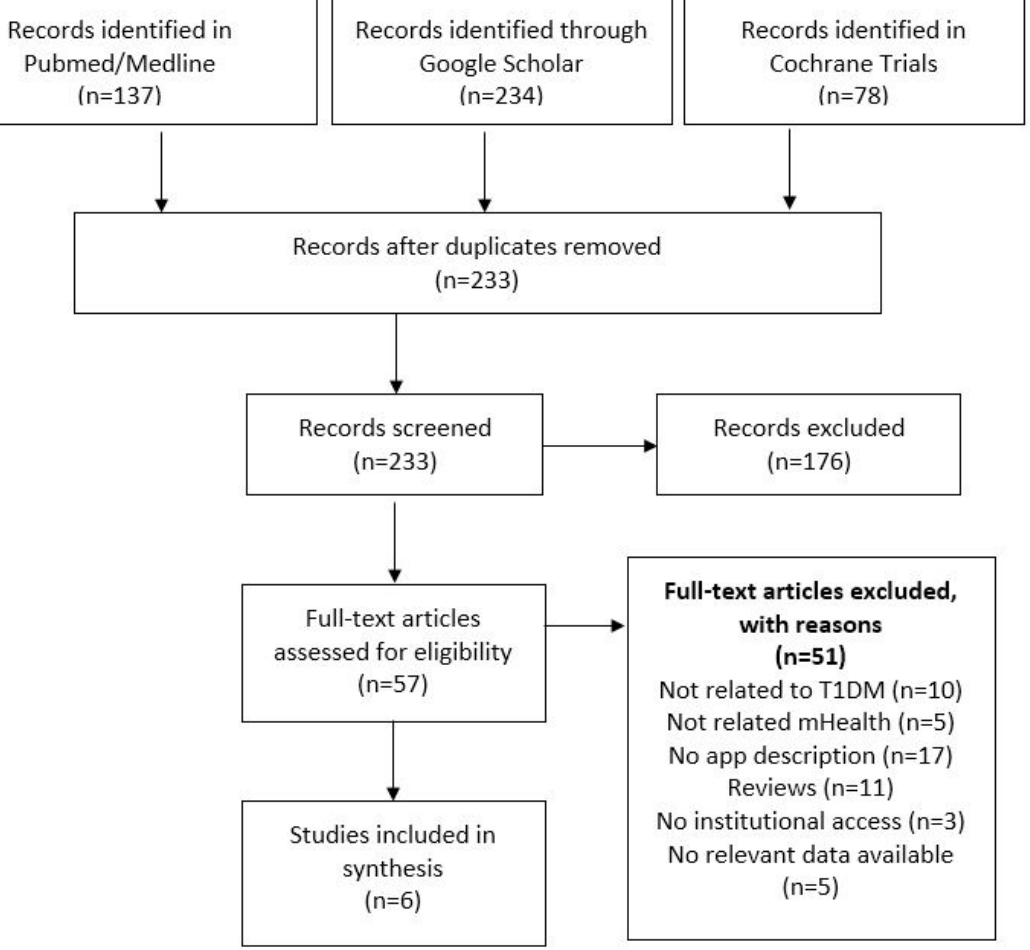
Figure 1. Selection of the literature for evidence-based features of mobile apps for type 1 diabetes management and